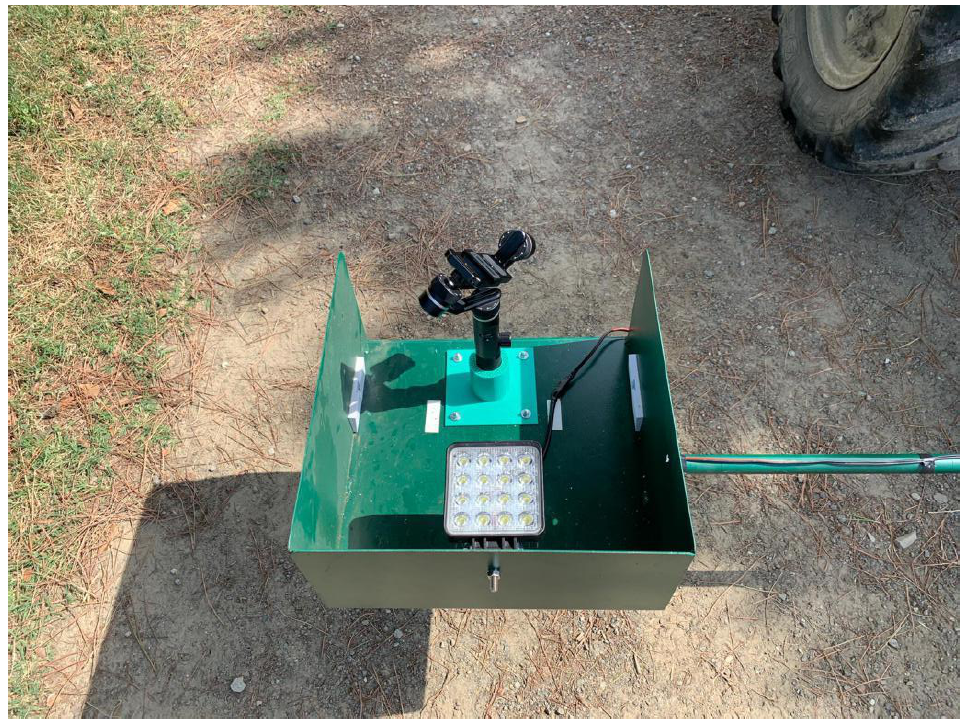
Figure 3. Gimbal, gimbal basis, and LED projector fixed on the bar and surrounded by a protective housing.